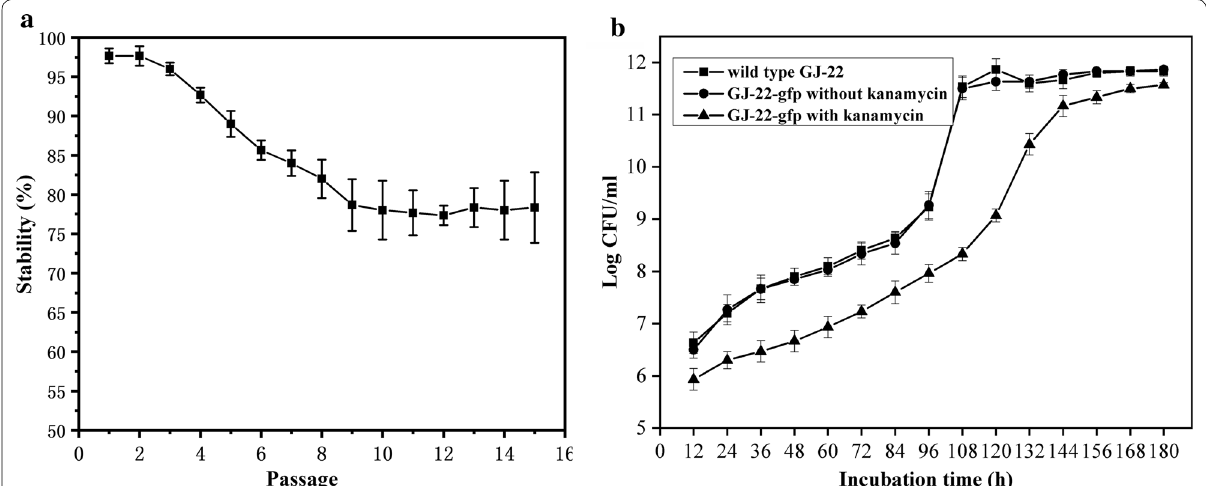
Fig. 2 a Genetic stability of strain GJ-22-gfp. Strain GJ-22-gfp was applied to PSB medium with and without kanamycin, samples were required every 96 h, repeated 15 times, and each time repeated 3 times. Comparative observation the number of transformants growing on selective and nonselective plates, and at the same time, both plates were observed under fluorescence microscope. After five passages, the maintenance was 90%. After nine passages, the stability of labeled strain maintained to 79%. b The growth curves of strain GJ-22 and GJ-22-gfp. Population expressed in log CFU mL − 1 , the figure square represents the wild type strain GJ-22, results indicates the strain GJ-22-gfp without kanamycin, and the triangle was the symbol of the strain GJ-22-gfp with kanamycin. Three strains were cultured in the same media at the same conditions. This